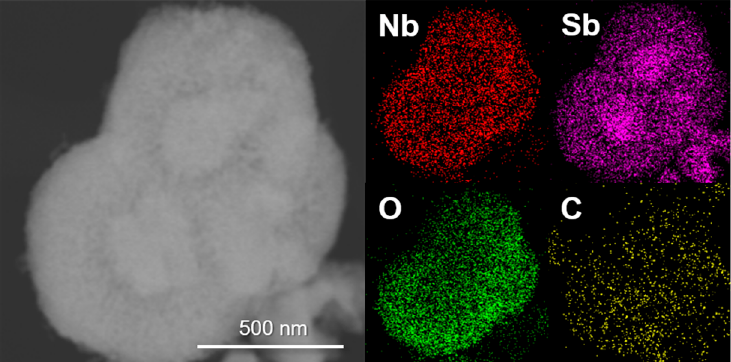
Figure 5. High-magnification TEM image and corresponding EDS elemental mapping results for each element in the spherical Sb core/Nb 2 O 5 -C double-shell structured composite.